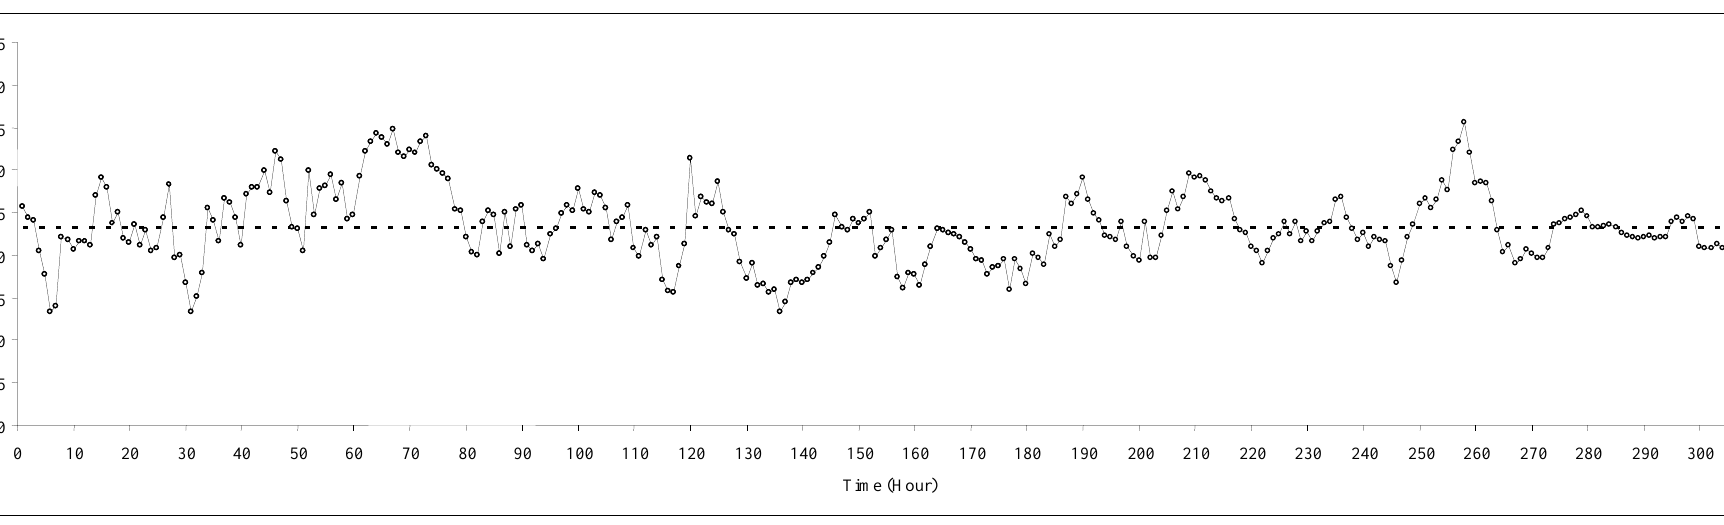
Figure 4. The variation in hourly RSE (%) values in the simultaneous measurement of CO RSE value for the entire study).